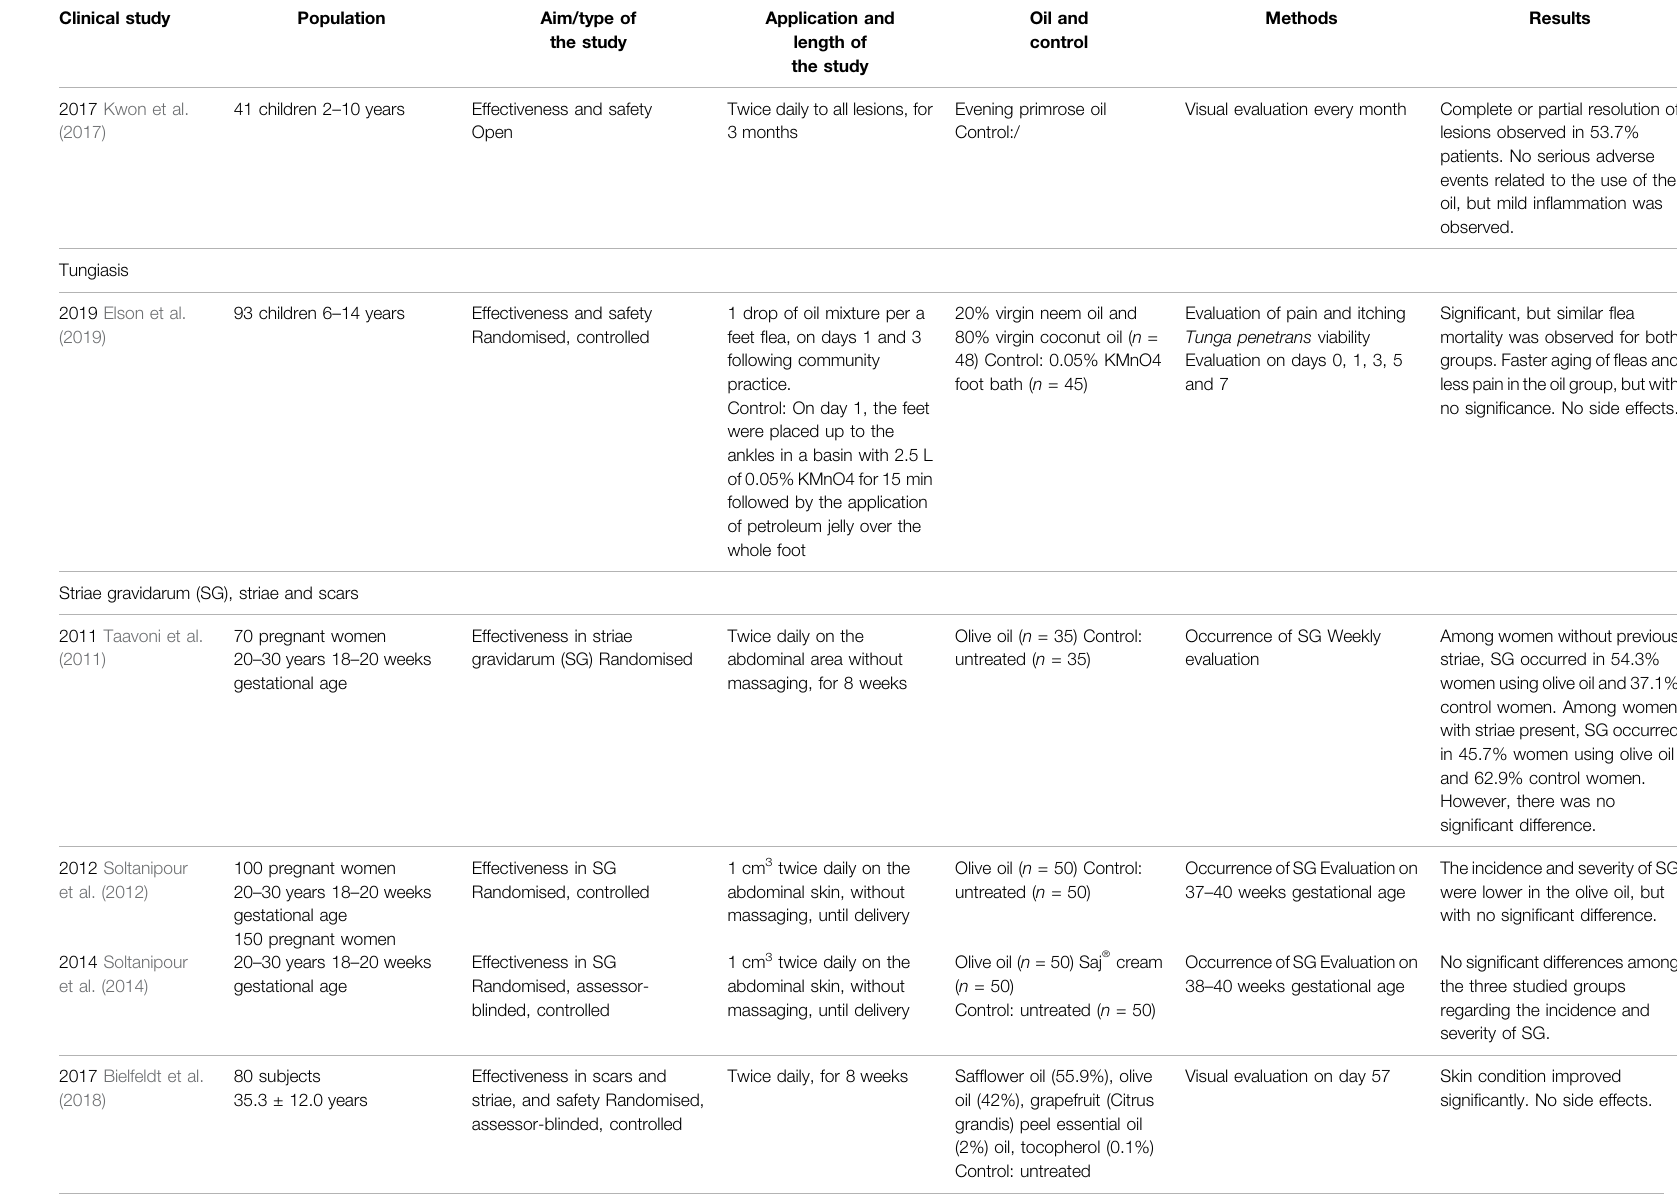
TABLE 4 | ( Continued ) Clinical studies evaluating the dermal effects of vegetable butters and oils. AD — atopic dermatitis, GC — gas chromatography, MC — molluscum contagiosum , SA — Staphylococcus aureus , SC — stratum corneum, SG — striae gravidarum, SLS — sodium lauryl